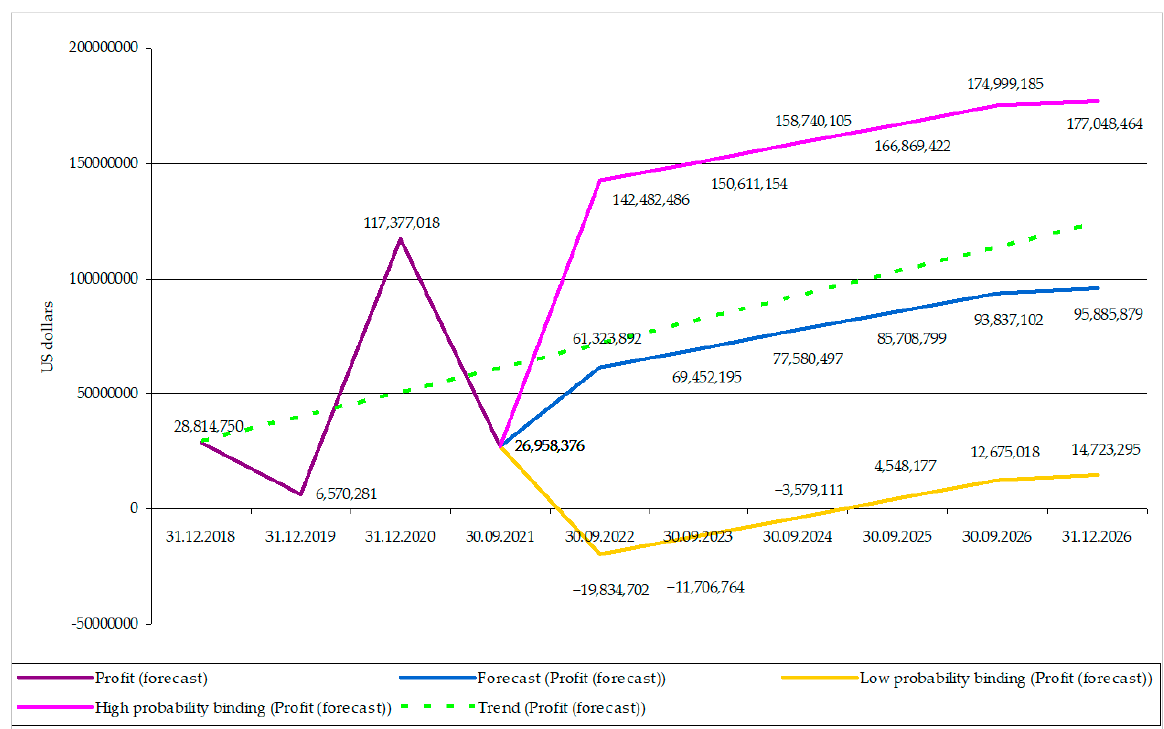
Figure 1. Bank profit trend (author’s